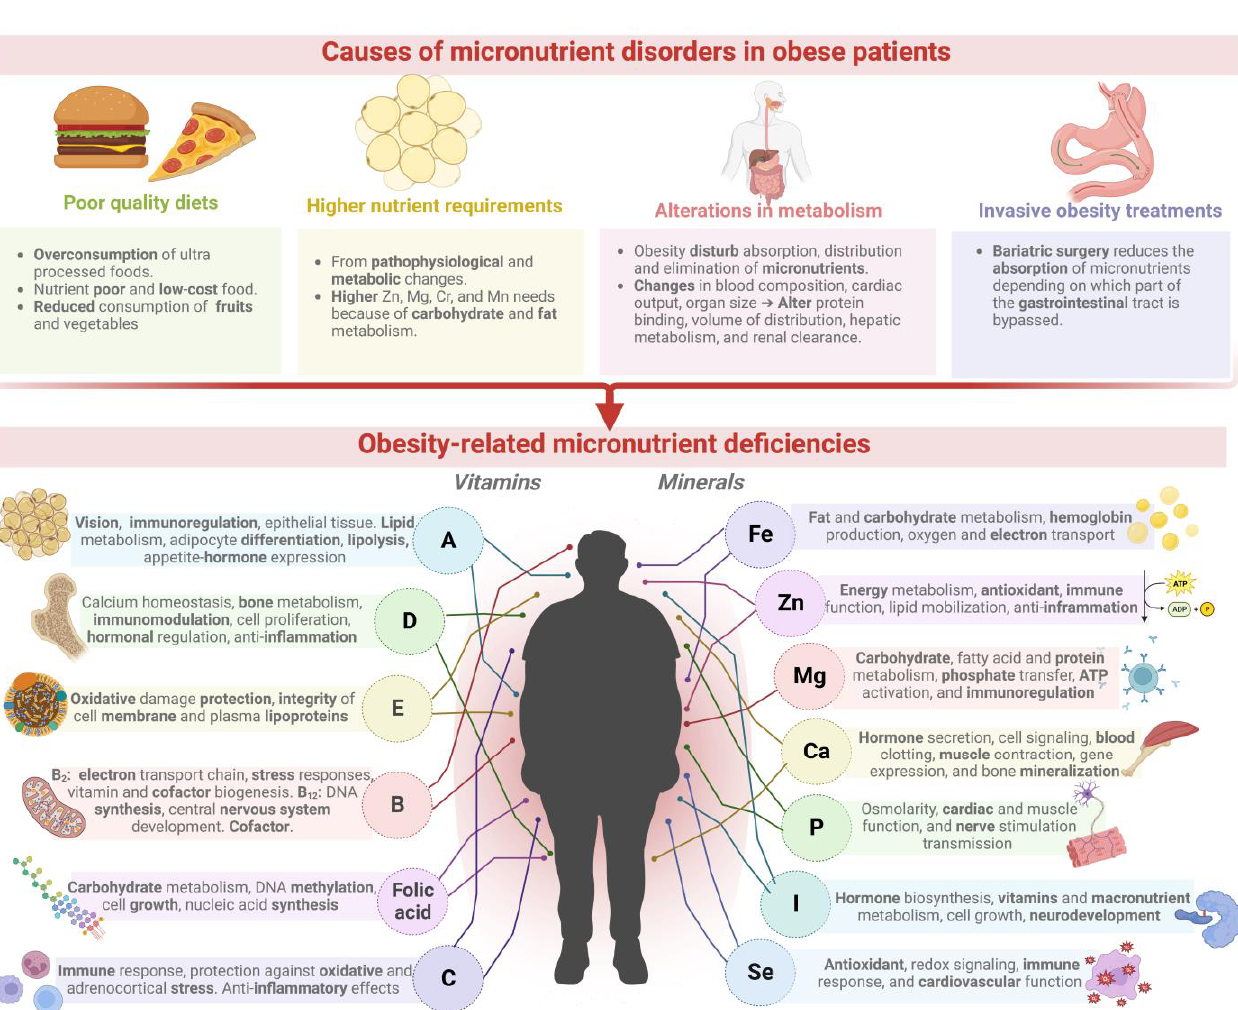
Figure 1. Micronutrient deficiencies associated with obese patients. Ca: calcium, Cr: chromium, Fe: iron, I: iodine, Mg: magnesium, Mn: manganese, P: phosphorus, Se: selenium, Zn: zinc. Figure cre- ated with BioRender.com. Table 1. Micronutrient deficiencies found in obese patients.